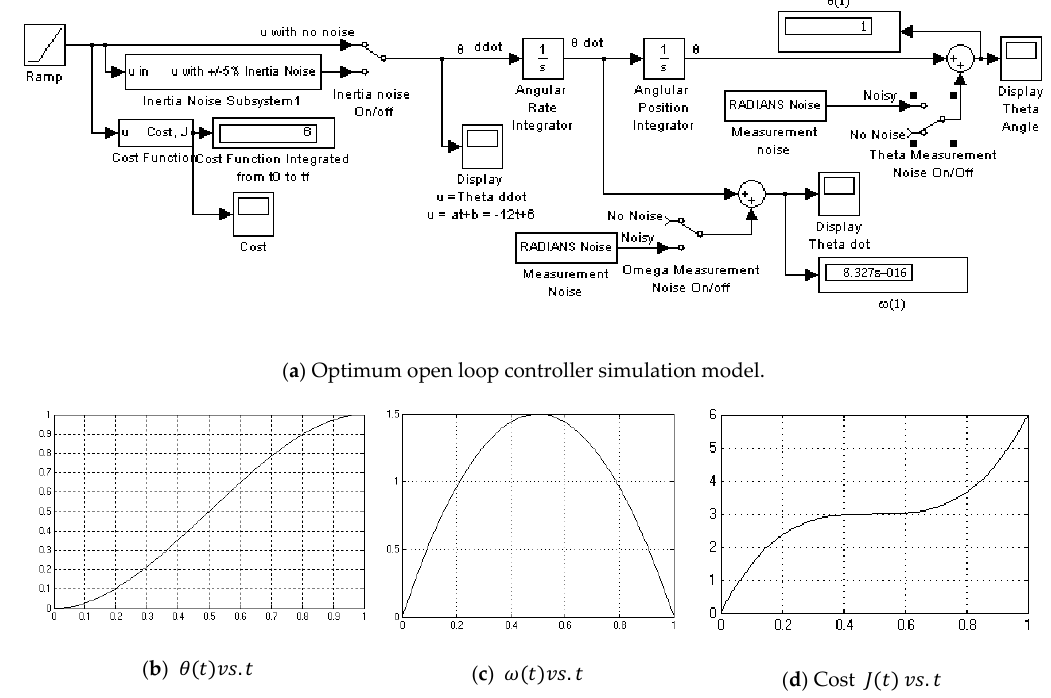
Figure A1. Optimum open loop controller simulation model and results.